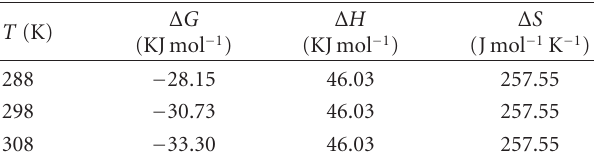
Table 3: Thermodynamic parameters for the binding of the Pt(II) complex to